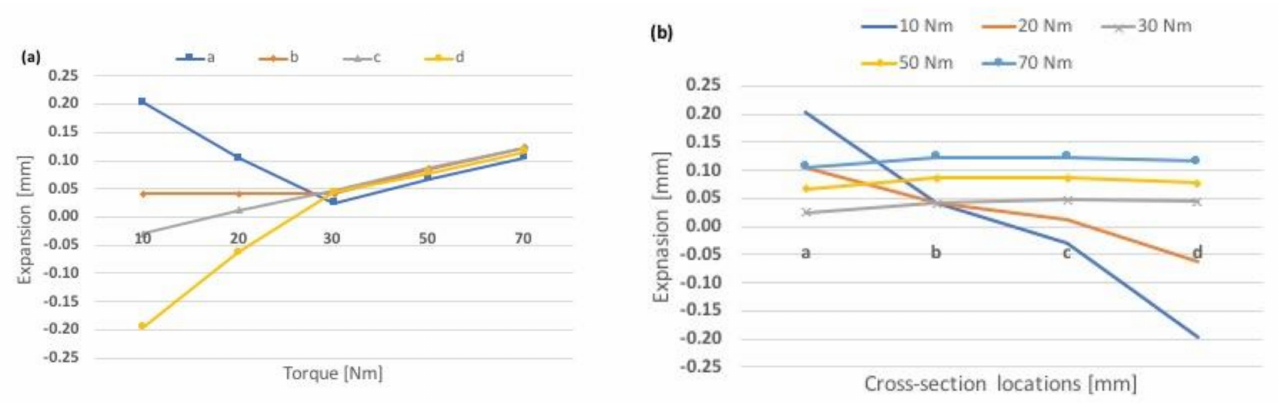
Figure 10. Test 1b—Ring deformations of non-lubricated bearing ring on double sleeve: ( a ) expansion as a function of torque and ( b ) expansion at different cross-section locations.